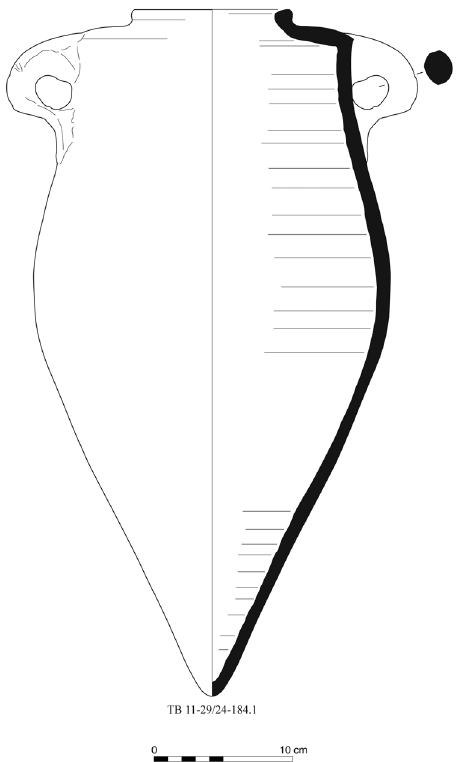
Figure 1: Persian Period amphora from Tell el - Burak ( form type A - 02C )